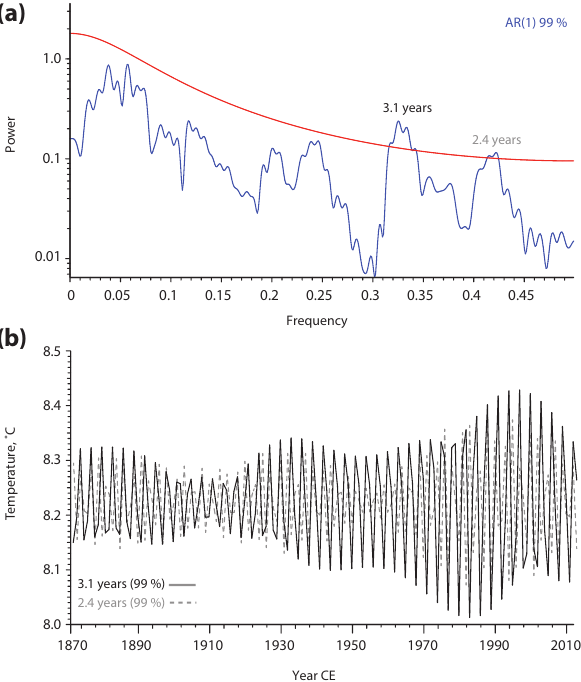
Figure 4. Tropical variability in the subantarctic temperature record. Changing amplitude of reconstructed summer temperatures for Macquarie Island. Multi-taper method (MTM) (a) and extracted climate periodicities exceeding 99% significance (b) observed in the Dracophyllum -derived growing season temperature reconstruc- tion for Macquarie Island since